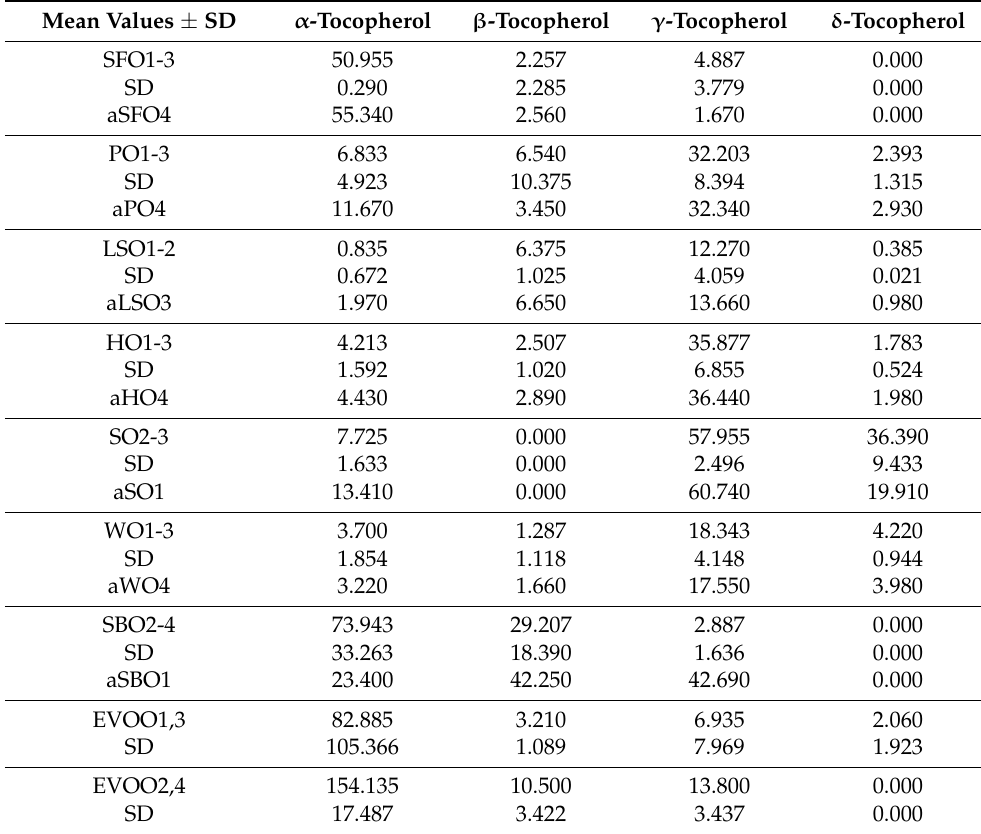
Table 4. Mean values (mg/100 g) of individual tocopherol isomers separated and identified in commercial and authentic oils. For oil abbreviations, see Table